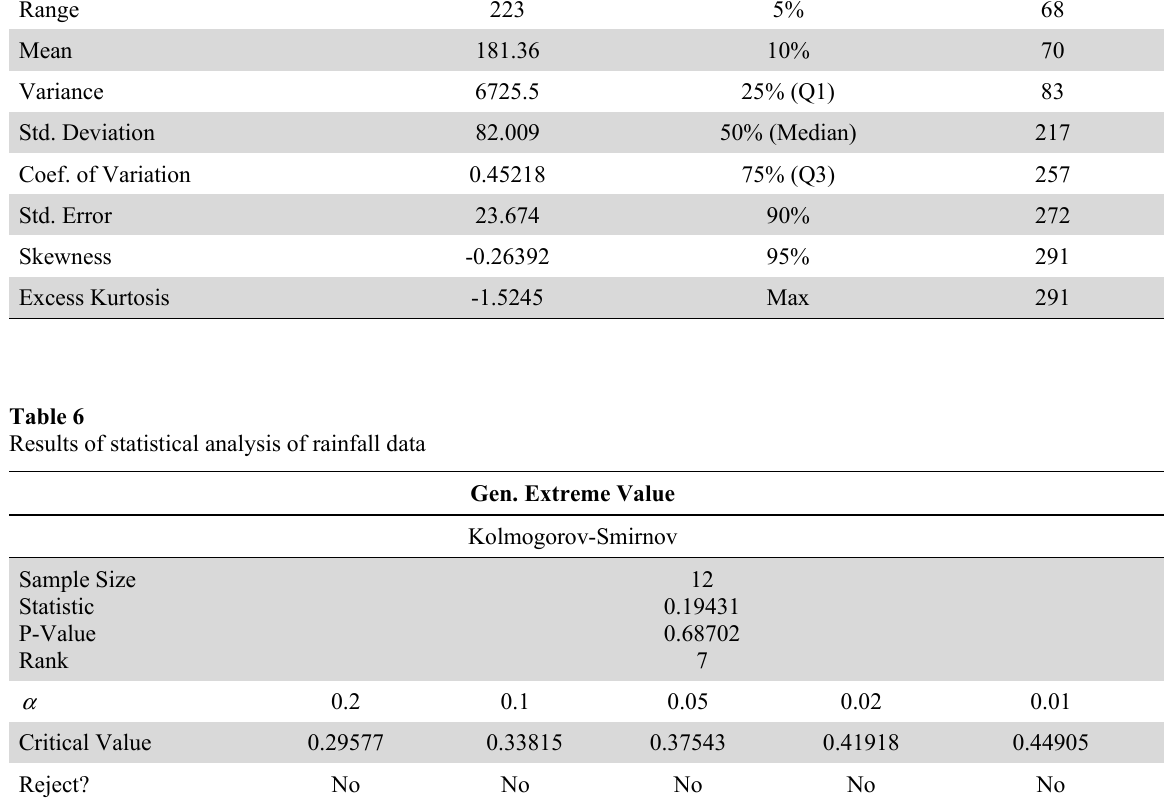
Results of statistical analysis of rainfall